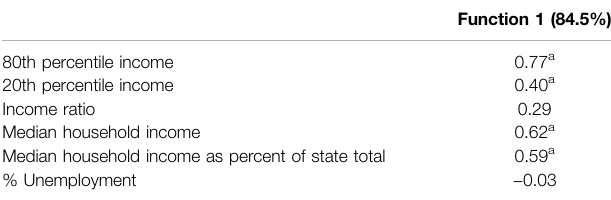
TABLE 8 | Discriminant analysis structure coef fi cients for income/employment variables by latent